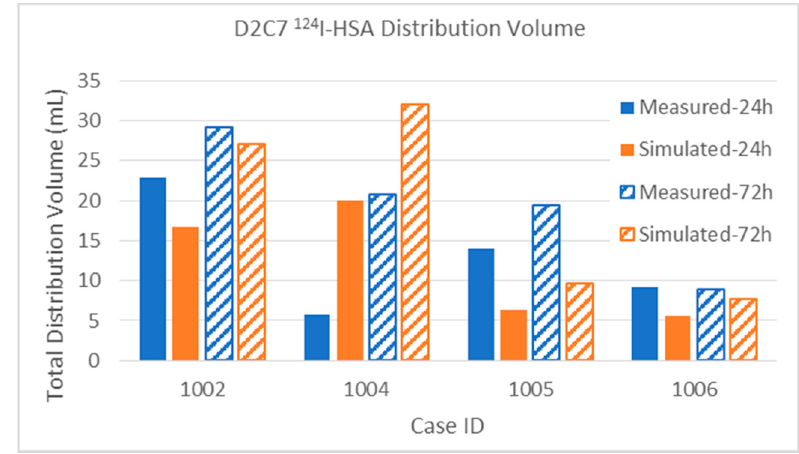
Figure 10. Comparison of measured and simulated 124 I-labeled human serum albumin distribution in D2C7 patients. These four patients each had a single catheter infused at 0.5 mL/h.